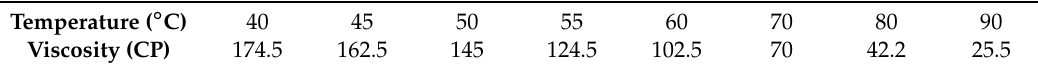
Table 2. Relationship between viscosity and temperature of chemical polyol waster liquor. Temperature ( ◦